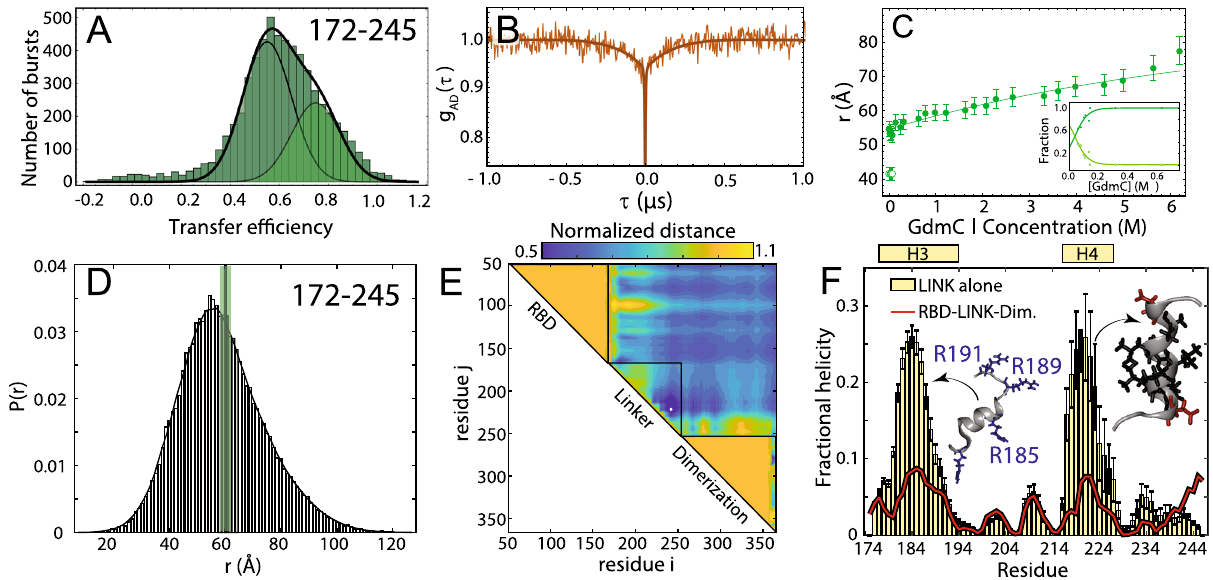
Fig. 3 The RNA-binding domain (RBD) and dimerization domains are interconnected by a fl exible disordered linker (LINK). A Histogram of the transfer ef fi ciency distribution measured across the labeling positions 172 and 245 in the context of the full-length protein, under aqueous buffer conditions. B Donor – acceptor cross-correlation measured by ns-FCS (see SI). The observed anticorrelated rise is the characteristic signature of FRET dynamics and the timescale associated is directly related to the recon fi guration time of the probed segment. C Interdye distance as extracted from single-molecule FRET experiments across different denaturant concentrations. The full line represents a fi t to the model in Eq. (S6), which accounts for denaturant binding. The inset provides an estimate of the fraction of each population in the low GdmCl concentration regime. Error bars are the propagation of ±0.03 systematic error in measured transfer ef fi ciencies (see SI). D Inter-residue distance distributions calculated from simulations (histogram) show good agreement with distances inferred from single-molecule FRET measurements (green bar). E Scaling maps reveal repulsive interactions between the N- and C-terminal regions of the LINK with the adjacent folded domains. We also observe relatively extensive intra-LINK interactions around helix H4 (see F ). F Two transient helices are observed in the linker (residues 177 – 194 and 216 – 227). The N-terminal helix H3 overlaps with part of the SR region and orientates three arginine residues in the same direction, analogous to behavior observed for H2 in the NTD. The C-terminal helix H4 overlaps with a Leu/Ala-rich motif and may be a conserved nuclear export signal (see “ Discussion ” ). Error bars are standard errors of the mean calculated from 30 independent